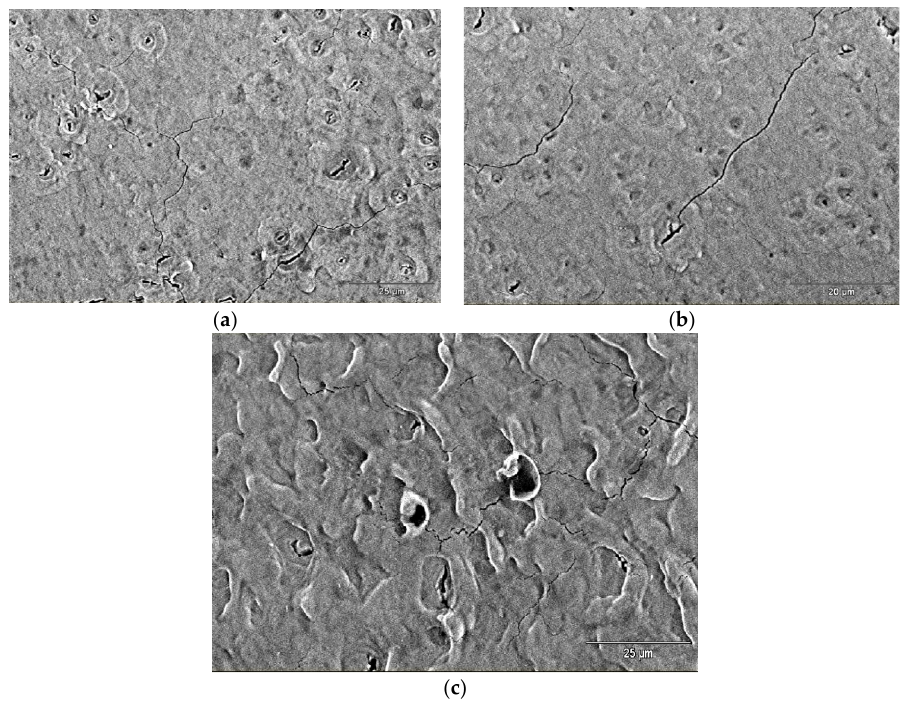
Figure 9. ( a – c ) The zone around the crater exhibits bubbles and long cracks often departing from the bubbles.